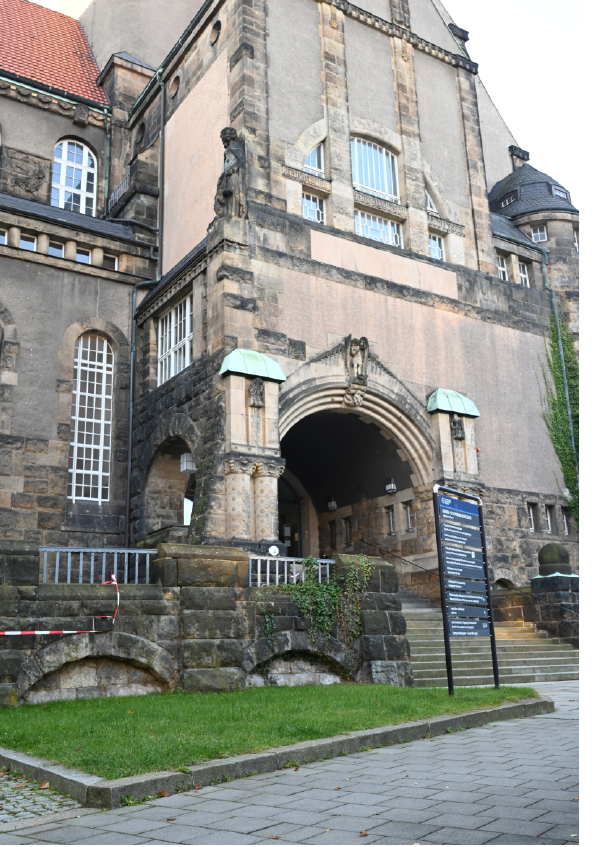
Figure 2. Contemporary image of the entrance portal of the Georg-Schumann-Bau and its closer